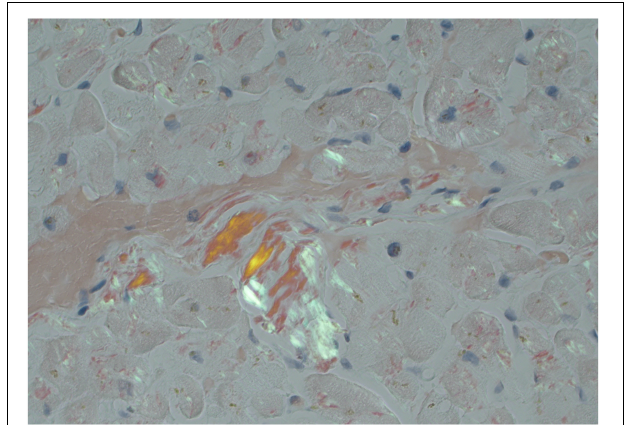
FIGURE 7 | Endomyocardial biopsy pathology in a patient with cardiac amyloidosis. Congo red stain at 10 × x magnification showing apple-green birefringence under polarized light consistent with amyloid